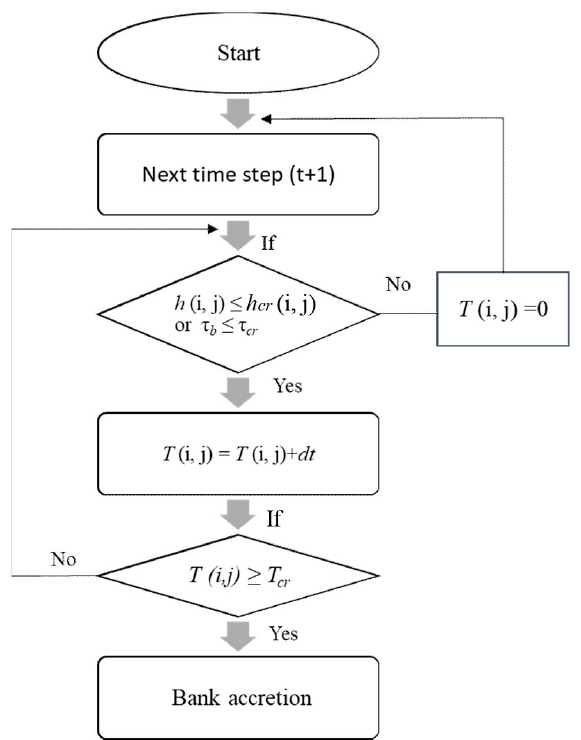
Figure 1. Flow diagram for the bank accretion calculations where h is the water depth; h cr is the critical depth for landing; dt is the time step in the calculation; and T (i, j) is the sum of the time of consecutive steps over which h ≤ h cr or τ b ≤ τ bc , the accretion will occur in those cells where the time T (i, j) exceeds a critical time for occurrence of bank accretion T cr (i, j).